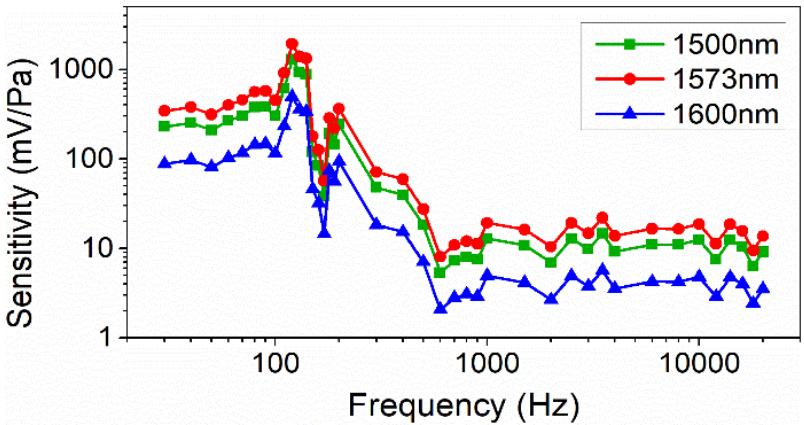
Figure 12. Sensitivity curves at different acoustic frequencies.